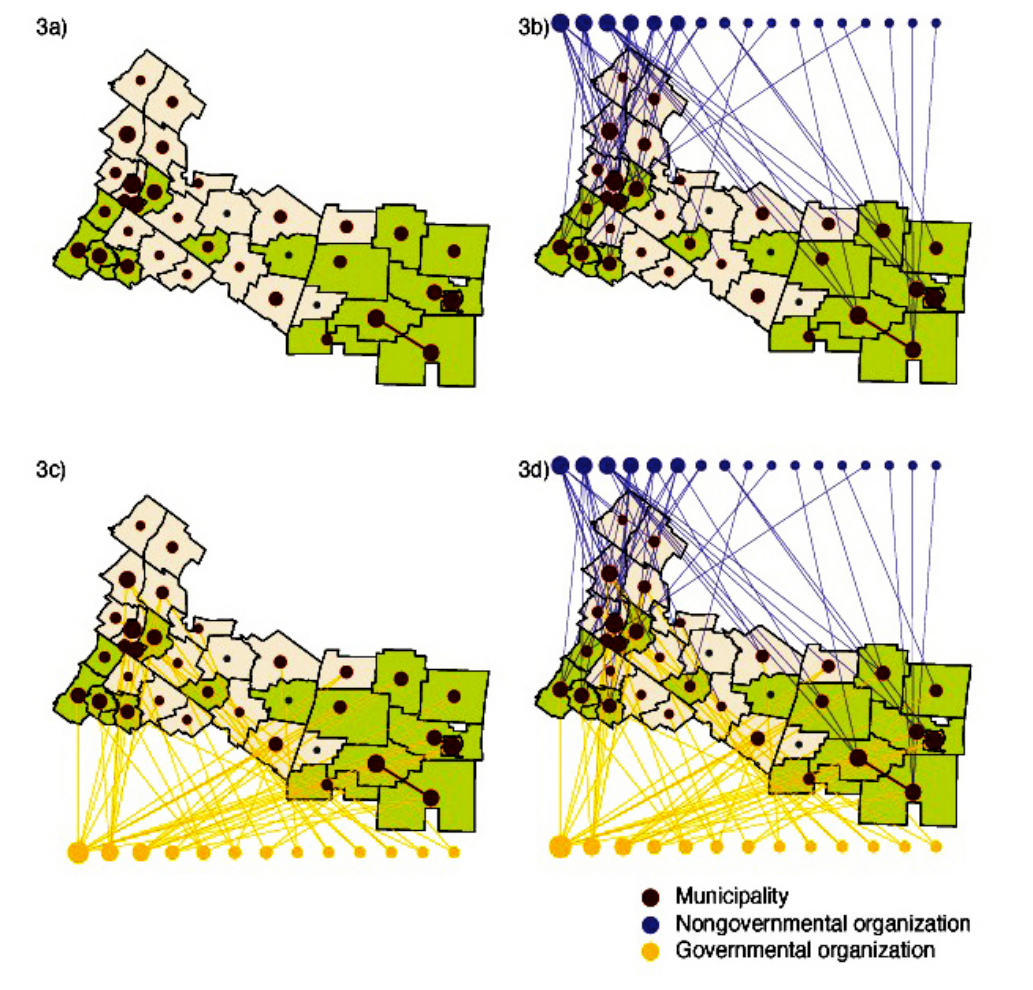
Fig. 3 . The social networks among municipalities for water quality management. The size of the red circle in each municipality corresponds the number of municipal links. Unlinked municipalities are shaded grey. a) Direct collaborations among municipalities (one-mode). b) Municipal collaborations with government agencies (two mode). c) Municipal collaborations with NGOs. d) All collaborations (one and two mode). Municipalities oriented toward agricultural production are shaded pink, while tourism oriented municipalities are shaded